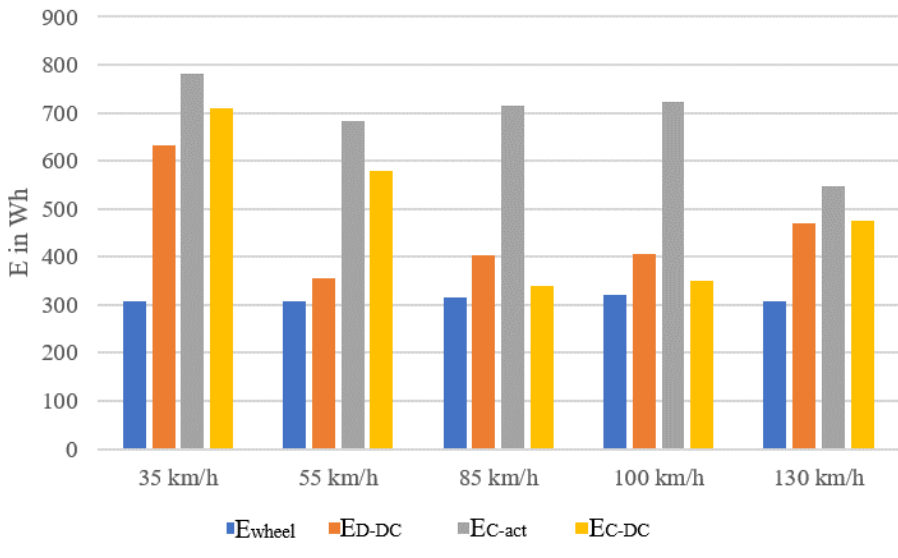
Figure 7. Energy consumptions of all driving